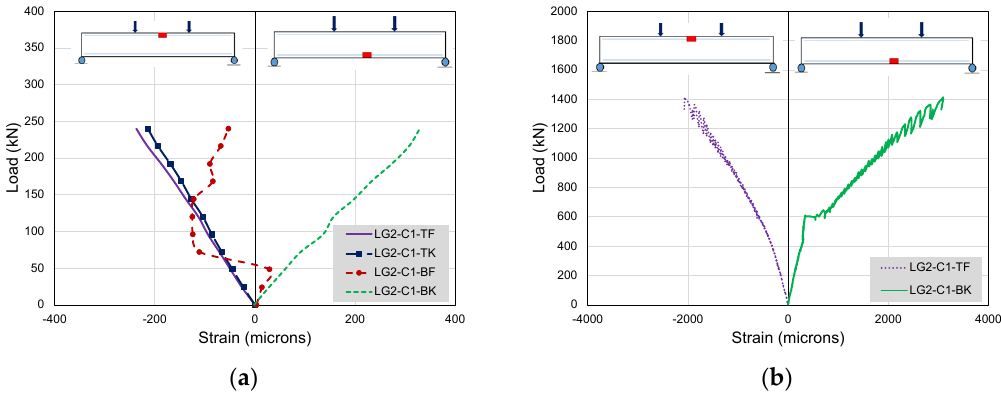
Figure 19. Strain versus load responses ( a ) load setup SP-2-L01 and ( b ) load setup SP-2-L02.